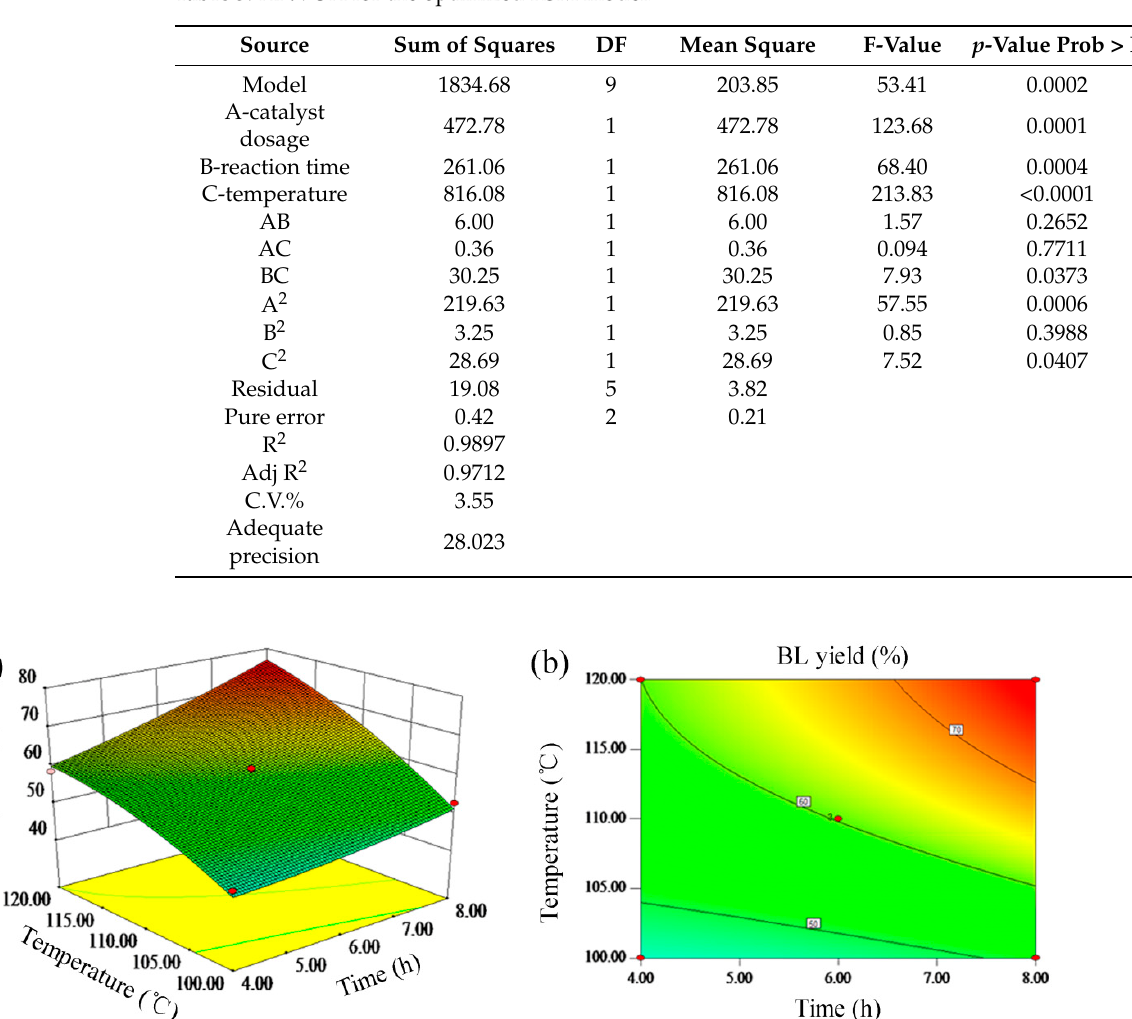
Figure 9. ( a ) 3D response surface plot and ( b ) contour plots for the mutual influences of reaction time and temperature on the BL yield.